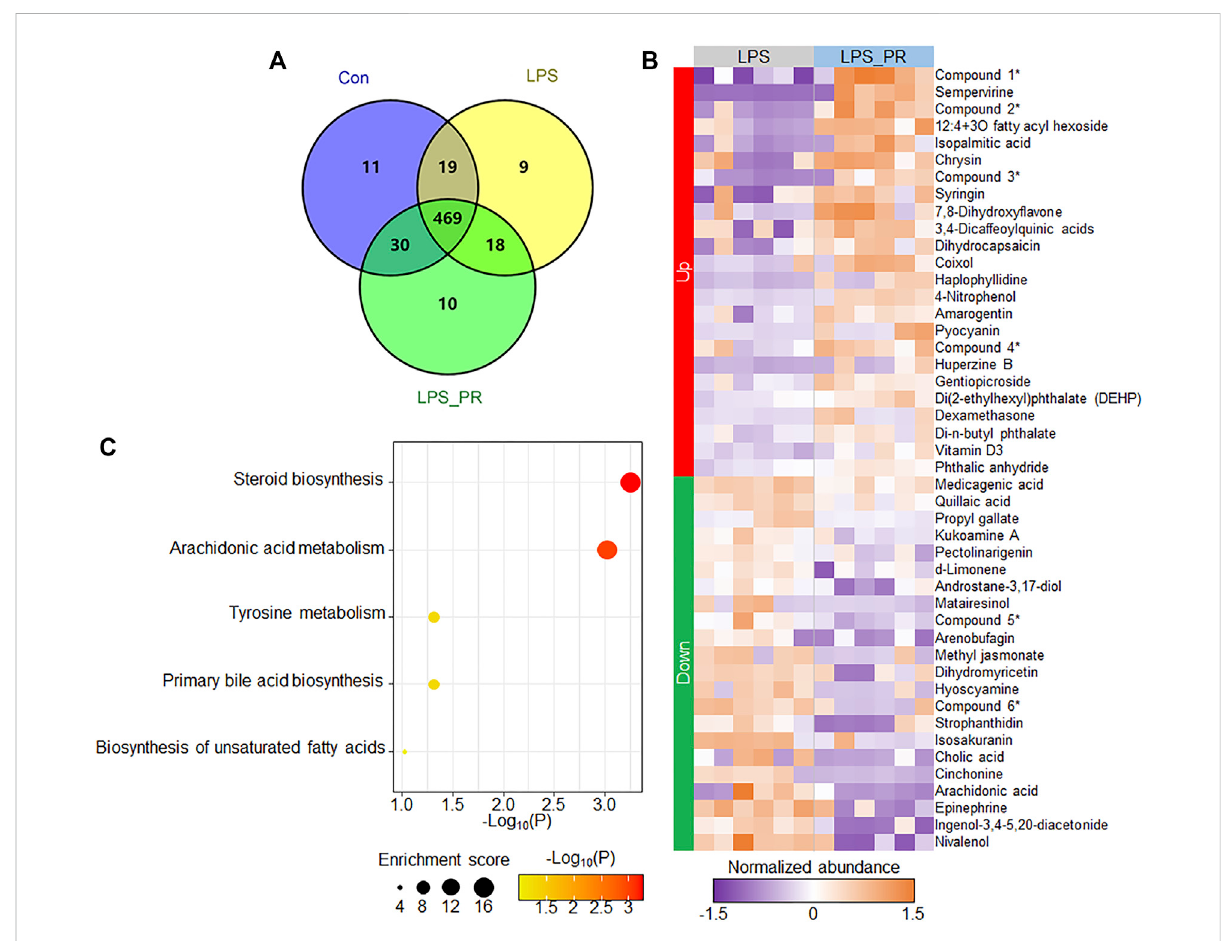
FIGURE 4 PR changed the serum metabolites of LPS-stimulated mouse. (A) Number of identi fi ed metabolites in the three types of experimental samples. (B) Heatmap of 46 differentially expressed metabolites in LPS and LPS_PR. Purple represents low expression and orange represents high expression. Duetothelongnamesofsomeingredients,abbreviationsareusedfordisplay(indicatedbyasterisksontherightsideoftheheatmap).Compound1: [(1S,6S,7R)-6-acetyloxy-1-(3-methylbutanoyloxy)spiro[4a,5,6,7a-tetrahydro-1H-cyclopenta[c]pyran-7,2 ′ -oxirane]-4-yl]methyl 3- methylbutanoate; Compound 2: Pyrrolo[1,2-a]pyrazine-1,4-dione, hexahydro-3-(1-methylethyl)-; Compound 3: (1S,2R,4aS,6aR,6bR,10S,12aR,14bS)-1,2,6b,9,9,12a-hexamethyl-10-[(2R,3R,4S,5S,6R)-3,4,5-trihydroxy-6-methyloxan-2-yl]oxy- 2,3,4,5,6,6a,7,8,8a,10,11,12,13,14b-tetradecahydro-1H-picene-4a,6a-dicarboxylic acid; Compound 4: (2S,3S,4S,5R,6S)-3,4,5-trihydroxy-6-(5- hydroxy-4-oxo-2-phenylchromen-7-yl)oxyoxane-2-carboxylic acid; Compound 5: